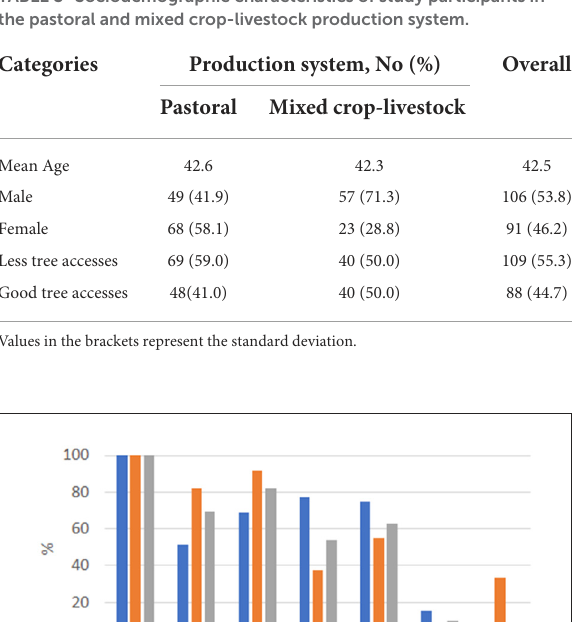
FIGURE2 Livestock ownership status of respondents based on production system in Ethiopia.